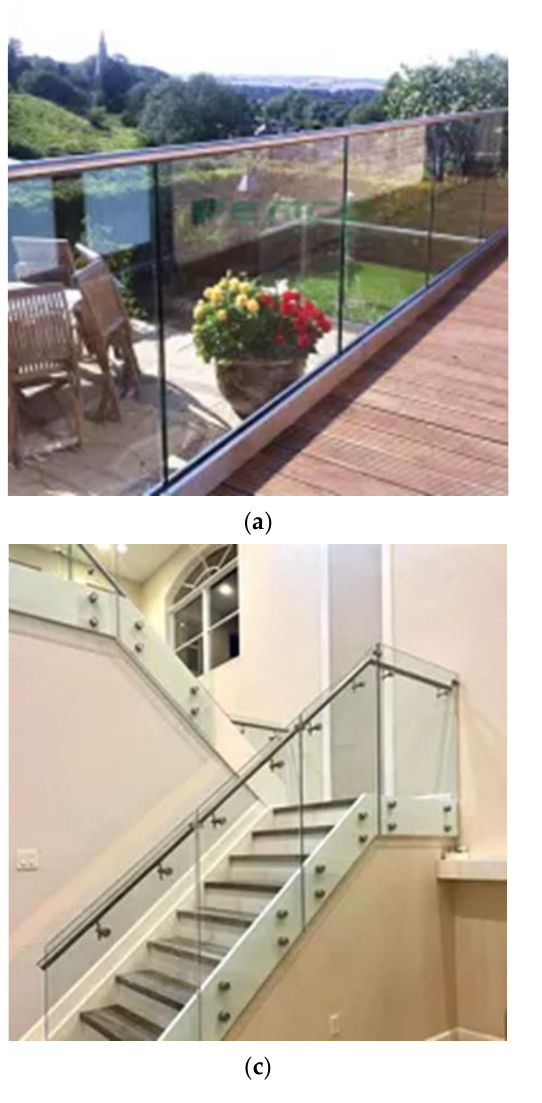
Figure 1. Examples of glass balustrades characterized by various restraint conditions: ( a ) linear restraint at the base; ( b ) point-fixing at the base; ( c ) top-bottom point-fixings; ( d ) lateral point-fixing. Solutions ( a , b ) do not require glass drilling; ( c , d ) are characterized by the presence of glass holes.